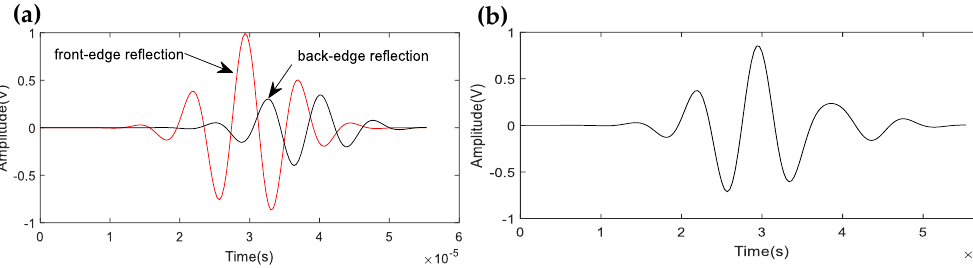
Figure 6. Wave propagation paths corresponding to the individual signals in a pipe with a reflector.